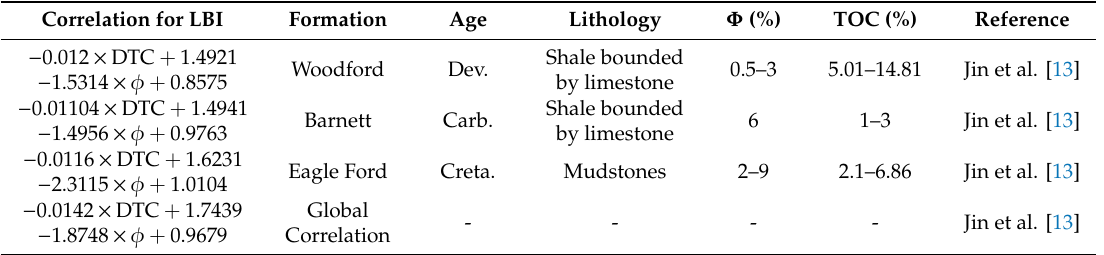
Table 2. Summary LBI correlations based on compressional wave travel time (DTC) and neutron porosity